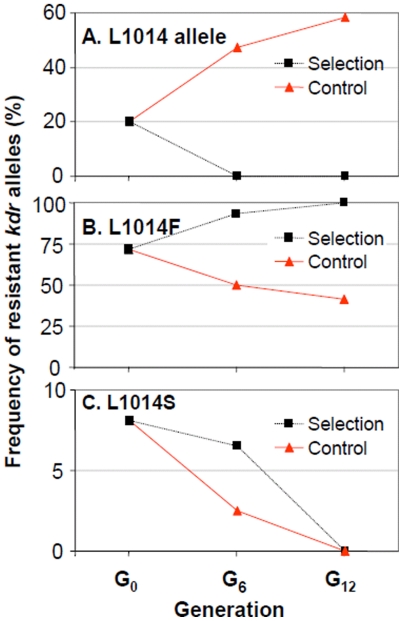
Dynamics of kdr allele frequency in response to deltamethrin selection.
A: wildtype L1014 allele frequency was significantly decreased under deltamethrin selection, but significantly increased in the absence of selection; B: L1014F allele frequency was significantly increased under selection, but significantly decreased when no insecticide selection pressure was available; and C: L1014S allele frequency was decreased regardless of deltamethrin selection.